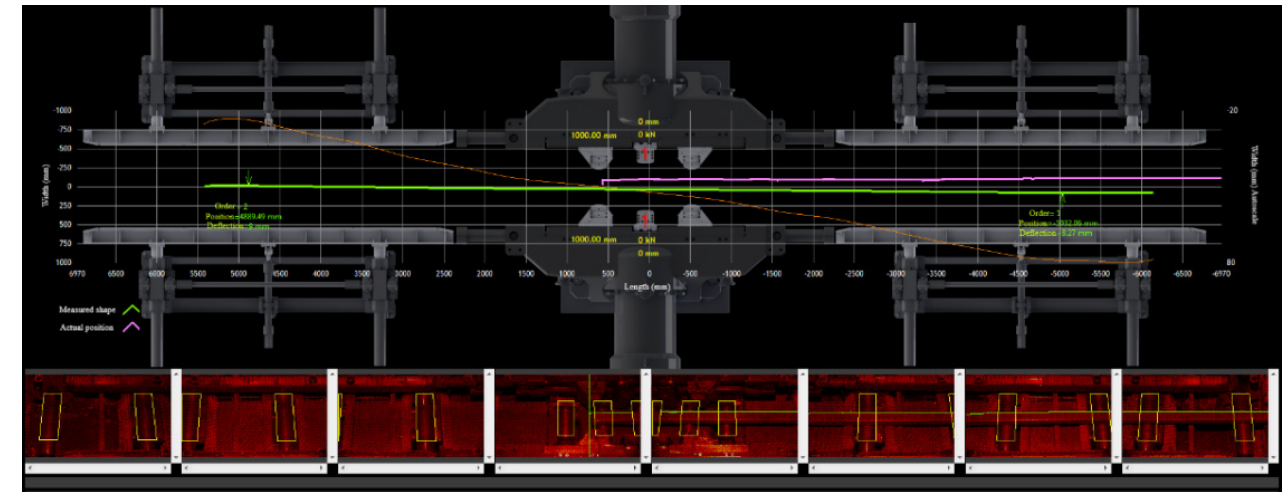
Figure 10. Visualization of initial billet shape and proposed strokes in the technology.